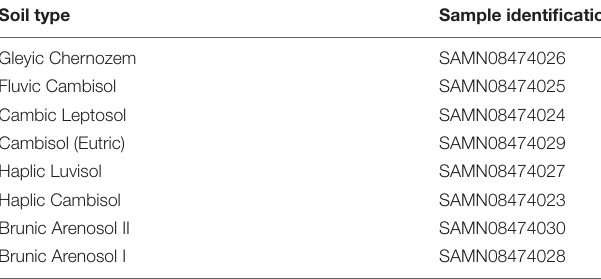
TABLE 3 | Summary of deposited raw sequences in fastq